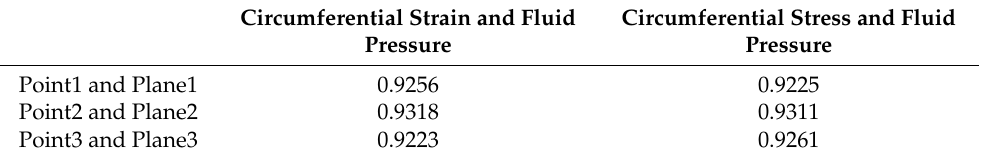
Table 1. Correlation coefficient.